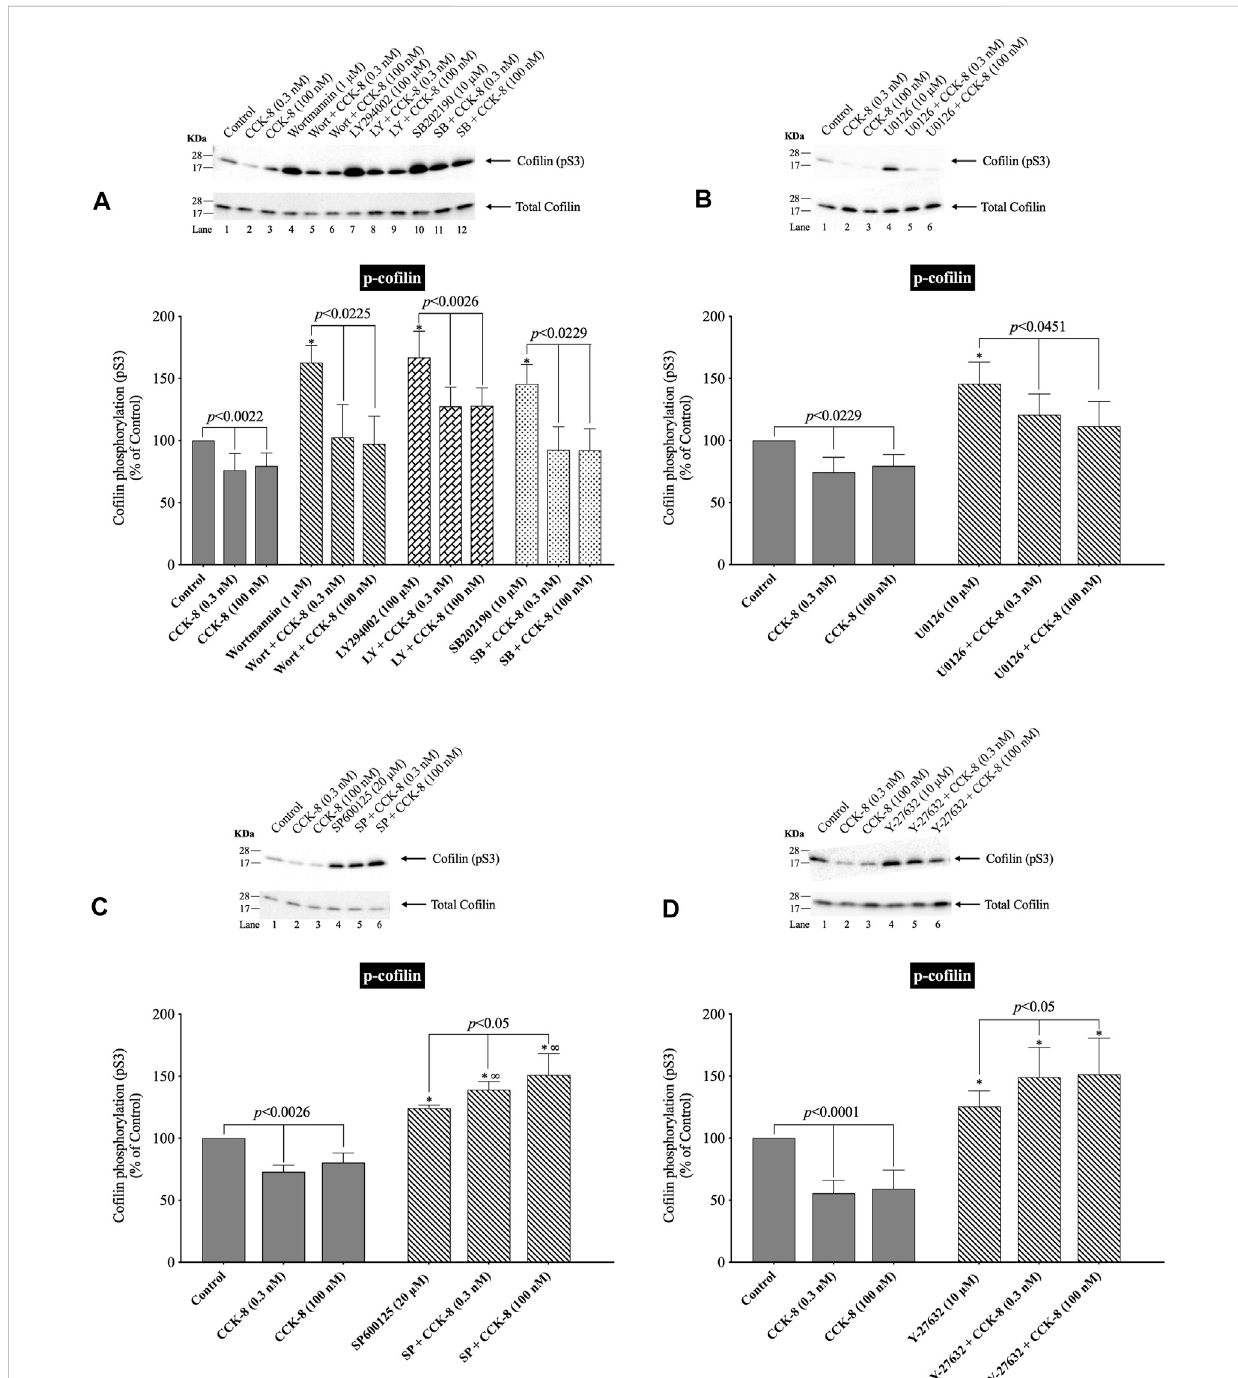
FIGURE 10 Effect of two PI3K inhibitors, Wortmannin (Wort) and LY294002 (LY); a p38 inhibitor, SB202190 (SB); a MEK inhibitor (U0126); a JNK inhibitor, SP600125 (SP); and a ROCK inhibitor, Y-27632, on the ability of CCK-8 (0.3 and 100 nM) to alter activation of co fi lin. Isolated pancreatic acini were incubated in theabsence orpresence ofWort(1 µM) (A) , LY (100 µM) (A) ,SB (10 µM) (A) , U0126(10 µM) (B) , SP600125 (20 µM) (C) or Y-27632 (10 µM) (D) for 1 h (SP600125, 3 h) and then incubated with no addition (control), CCK-8 (0.3 and 100 nM, 3 min) and then lysed. Western blots were analyzed using anti-pS3 co fi lin. Bands were visualized using chemiluminescence and quanti fi ed by densitometry. Top : Results of a representative blot of four independent experiments are shown. Bottom : Means ± S.E. of at least 4 independent experiments. Results are expressed as % of basal stimulation of the control group. *, p < 0.05 compared to the control group; ∞ , p < 0.05 compared to stimulants without